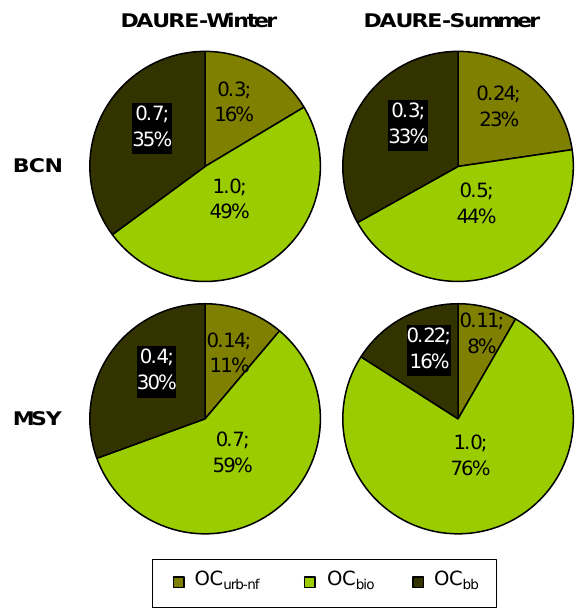
Fig. 3. Source apportionment to non-fossil organic carbon (µgm − 3 ). OC urb − nf : urban nonfossil organic carbon; OC bio : bio- genic organic carbon; OC bb : biomass burning organic